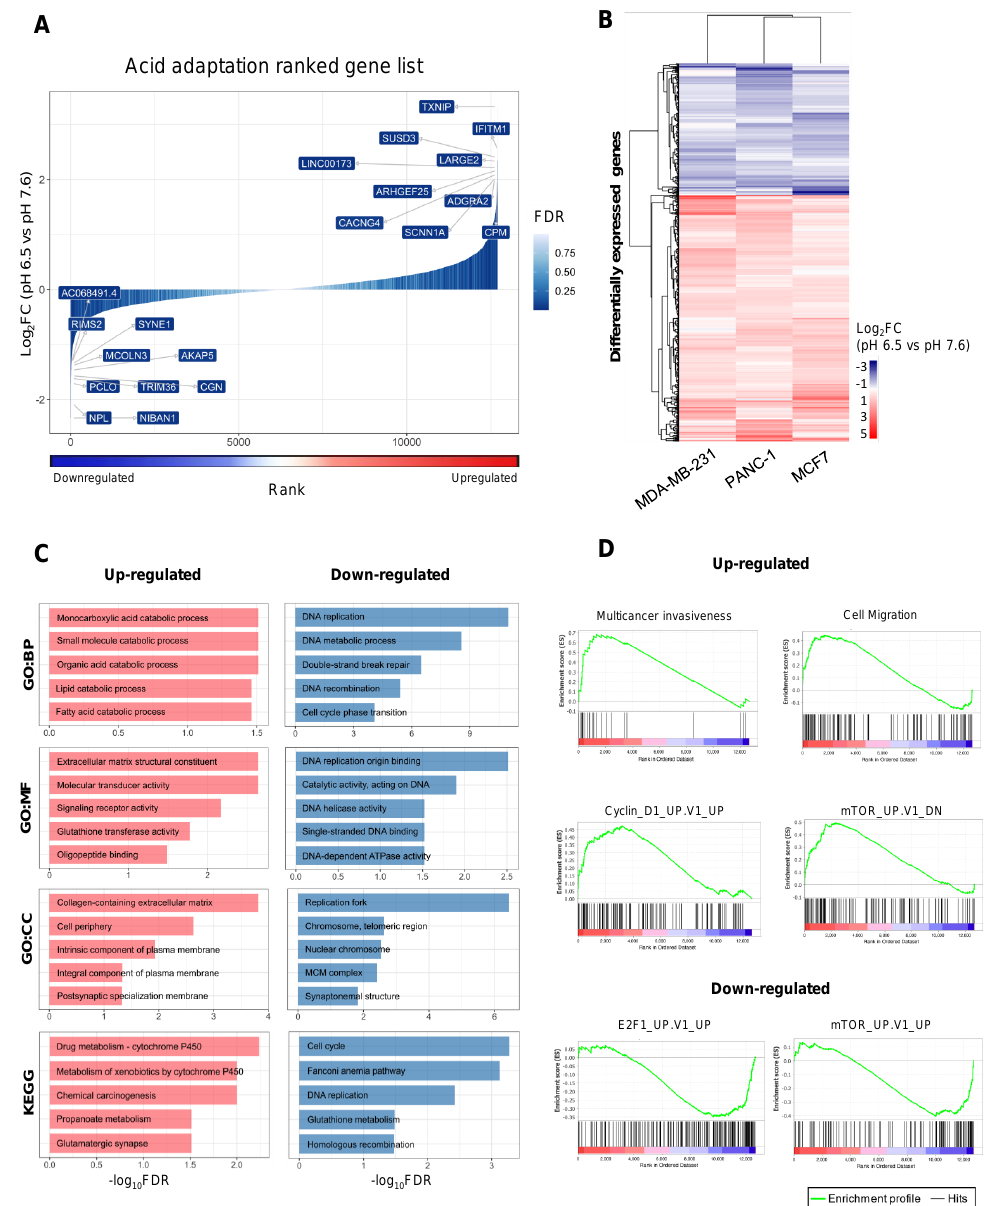
Figure 2. Identification of a shared acid adaptation expression response. ( A ) Fold change-based ranking of allgenesdifferentiallyexpressedinchronicallyacid-adaptedcancercells. The x -axiscorrespondstotherank assigned to each gene from 1 to N based on gene expression fold change (pH 6.5 vs. pH 7.6) in log 2 scale ( y -axis), also illustrated by blue–red gradient below. Bar color intensity indicates differential expression significance, expressedasfalsediscoveryrate(FDR).Geneswiththelargestabsolutefoldchangearelabelled on the plot. ( B ) Heatmap visualization of differential expression change in chronically acid-adapted cells. Rows correspond to significantly differentially expressed genes (480 upregulated and 256 downregulated), and columns correspond to three cancer cell lines (MDA-MB-231, PANC-1 and MCF7). Color indicates average log 2 fold change of gene expression (pH 6.5 vs. pH 7.6) across three replicates per condition. ( C ) Gene Ontology (GO) term analysis of differentially expressed genes in chronically acid-adapted cells. The x -axis shows GO term enrichment FDR values in − log 10 scale for differentially expressed genes defined above. The y -axis shows the top 5 GO terms from three categories (BP—Biological process, MF—Molecular function, CC—Cellular Component) and pathways from the KEGG (Kyoto Encyclopedia of Genes and Genomes) database, ordered by FDR. Bar colors correspond to up- or downregulated gene sets as in ( B , D ) Gene set enrichment analyses (GSEA) based on acid adaptation-ranked gene list from A to gene lists in the SigDB database. A subset of comparisons is shown as GSEA plots: the SigDB gene list